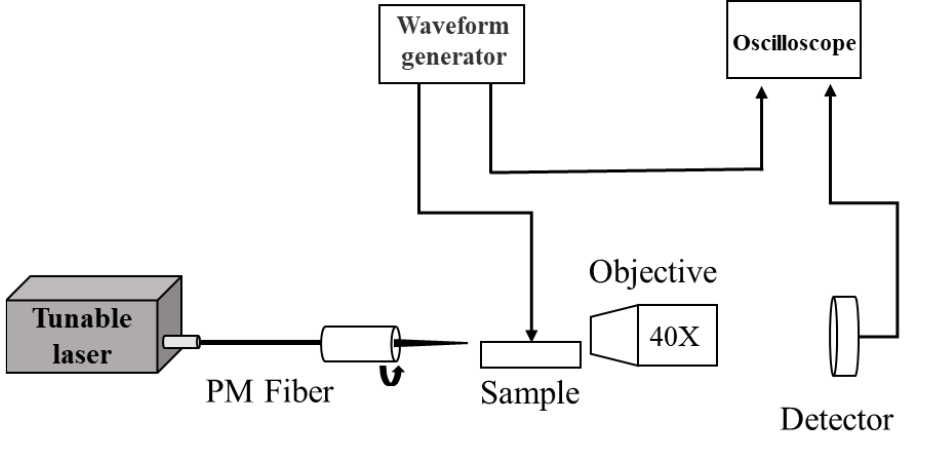
Figure 4. V π measurement setup.